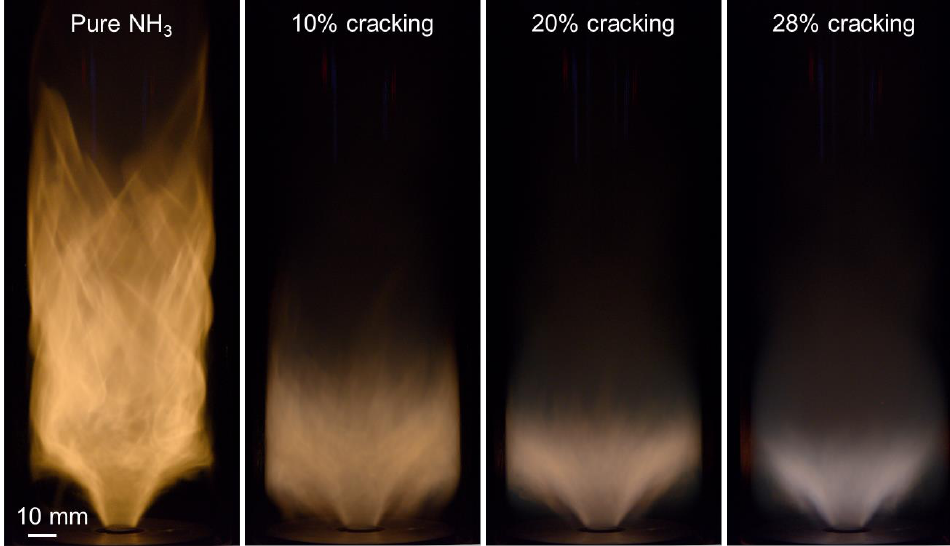
Figure 1. Direct visualization of ammonia, ammonia at 10% cracking, ammonia at 20% cracking, and ammonia at 28% cracking flames, with a thermal power of 3.4 kW, a bulk flow velocity of 7 m/s, an equivalence ratio of 0.95, and a swirl number of 1.67.